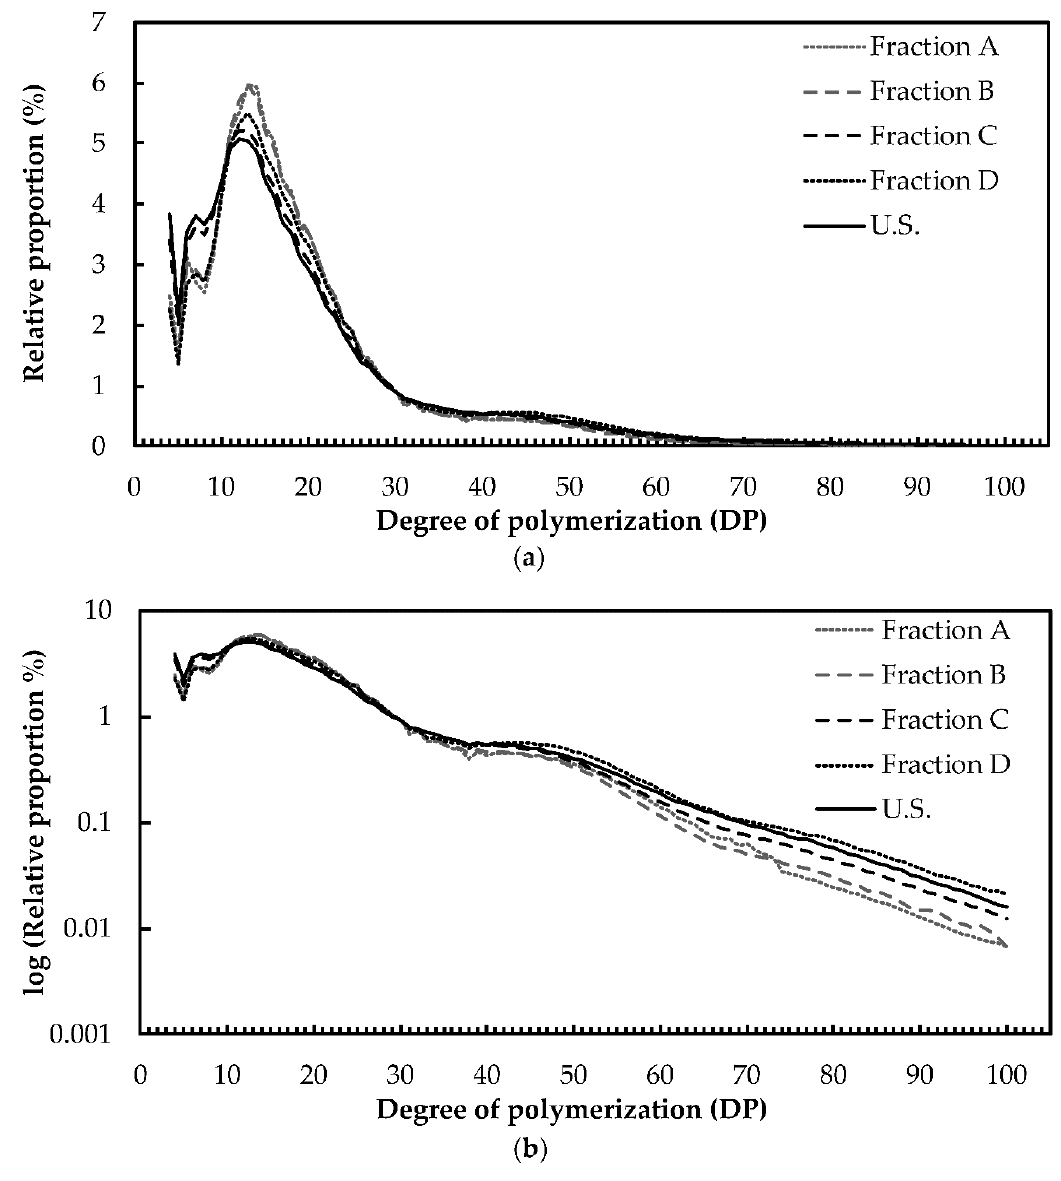
Figure 4. Amylopectin chain length distribution. One milligram of starch from each fraction and unfractionated starch (U.S.) was derivatized with APTS after enzymatic digestion by pullulanase and isoamylase. Peaks corresponding to DP 4 to DP 100 were integrated and their relative proportion in % is displayed. ( a ) Chain length distribution in linear scale. ( b ) Chain length distribution in log 10 scale. Glucan chain proportion was averaged from analyses of two independent fractionations.